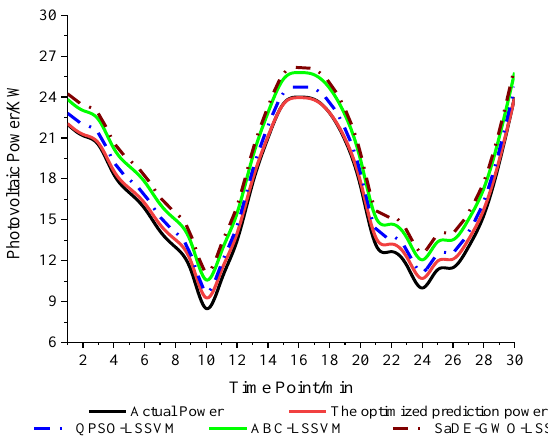
Figure 9. Fitting diagram of the optimized predicted power.